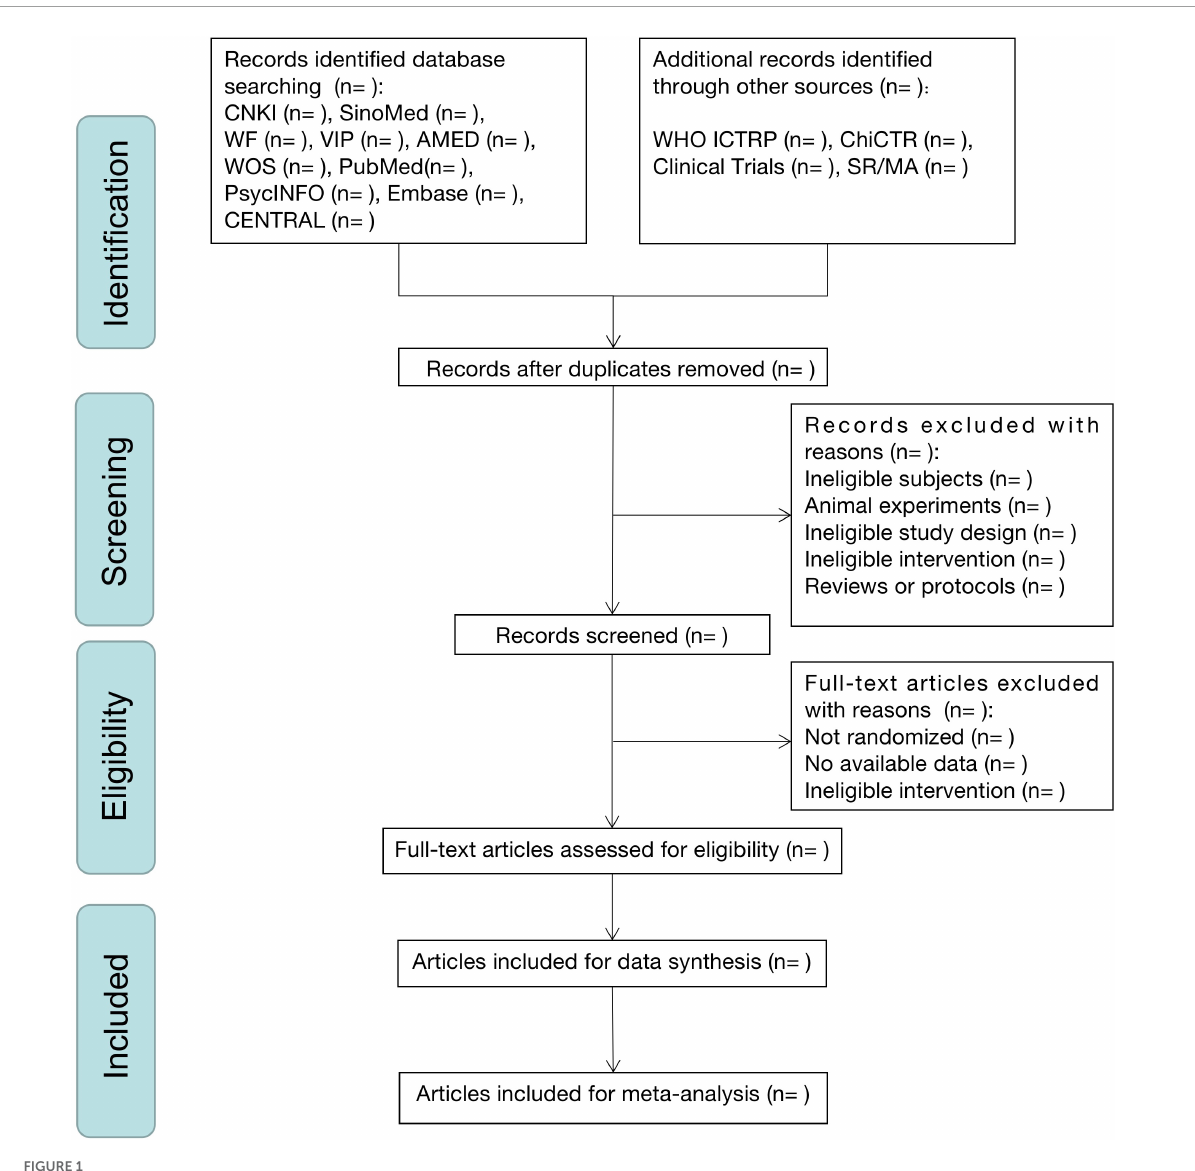
FIGURE1 Flow chart of the selection